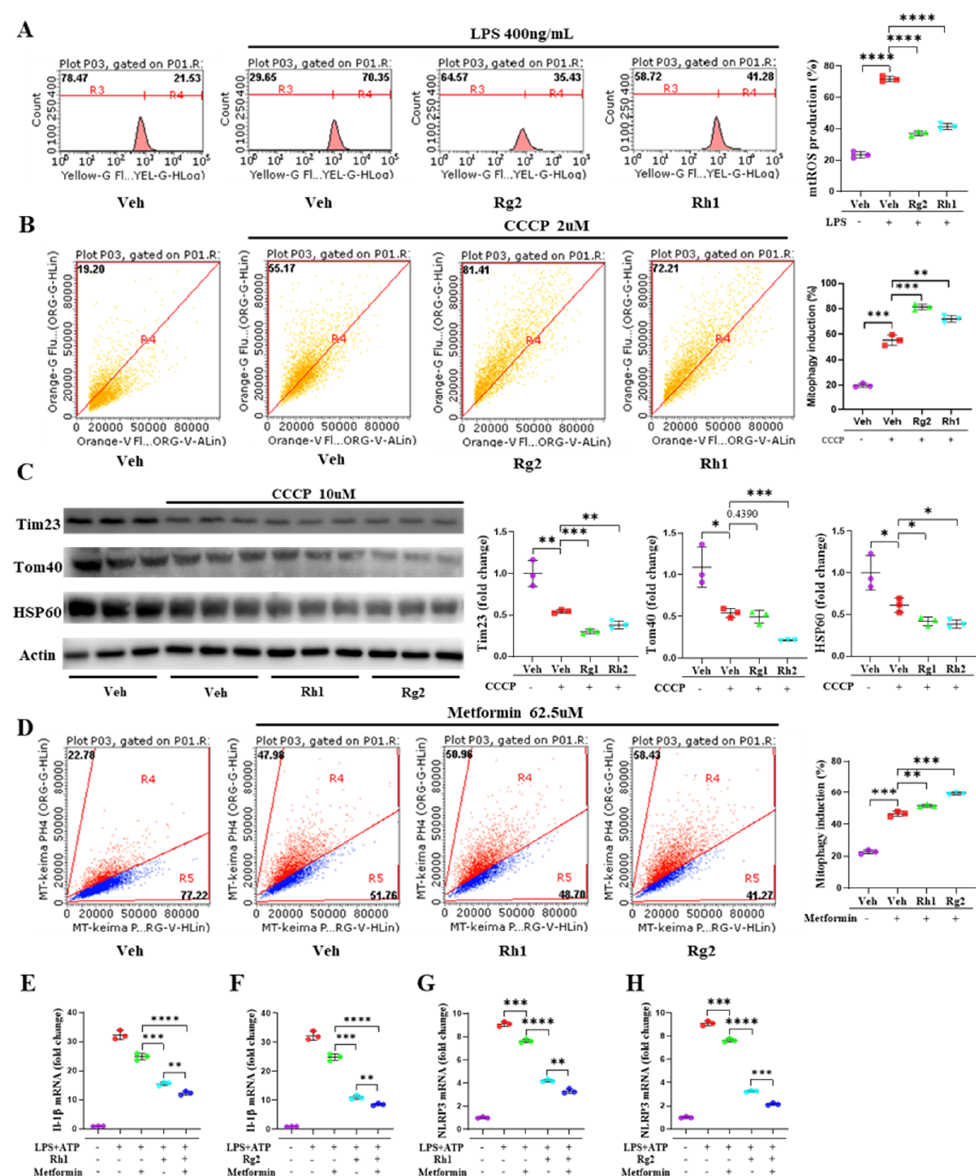
Figure 6. Ginsenoside Rh1 and Rg2 alleviated the activation of NLRP3 by promoting mitophagy. ( A ) ImKCs were measured for MitoSOX 3 h after treatment with LPS (500 ng/mL) and ginsenoside Rh1 (62.5 µg/mL) and Rg2 (62.5 µg/mL). ( B ) Hep3B cells were transfected with pLVX-puro-mt-Keima. Analysis of expressing mt-Keima treated with ginsenoside Rh1 and Rg2 for 24 h. Rh1 and Rg2 mediated mitophagy was quantified by flow cytometry with 2-µM carbonyl cyanide m-chlorophenylhydrazone (CCCP); the excitation wavelength was 586 nm in a neutral and 440 nm in an acidic environment. ( C ) Representative Western blotting analysis of Tim23, Tom40, and HSP60. The concentration of ginsenoside Rh1 and Rg2 was 62.5 µg/mL. ( D ) Ginsenoside Rh1 and Rg2-mediated mitophagy was quantified by flow cytometry with 62.5-µM metformin for 24 h in mt-Keima Hep3B cells. The mRNA expression of IL-1β in ImKCs cotreated with LPS+ATP, Metformin, and Rh1 ( E ) and Rg2 ( F ). The mRNA expression of the NLRP3 inflammasome in ImKCs cotreated with LPS+ATP, Metformin, and Rh1 ( G ) and Rg2 ( H ). Relative mRNA expression levels were normalized to mouse GAPDH levels. The data are expressed as means ± sem. * p < 0.05, ** p < 0.01, *** p < 0.001, and **** p < 0.0001.